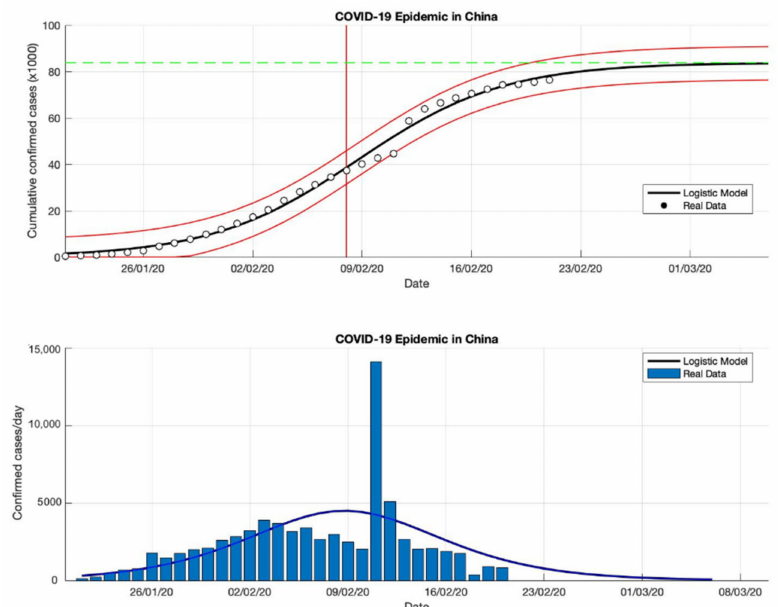
Figure 1. In the above figure, the prediction results of the logistic growth model for cumulative infected cases are compared with the actual data, while the two red lines between the black lines represent a prediction error limit of about 5%. The dashed green line predicts the total size of infected cases in the final phase of the epidemic. The red line intersects the cumulative case curve to predict the turning point or peak point of the epidemic (this line is parallel to the top of the curve from the below figure). In the below figure, the prediction results of this model for daily infected cases